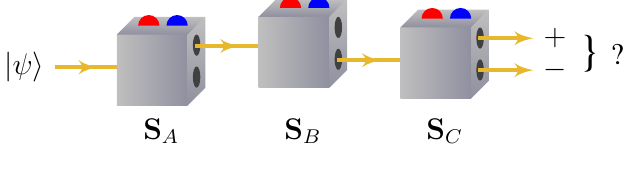
Figure 1. Each box represents a measurement of the spin for a spin- 1 axis with the top output indicating that the state is aligned ( + ) with the measurement axis and the bottom output indicating that the state is anti-aligned ( − ) with the measurement axis. Red and blue lights on the top simply indicate to the experimenter which of the two results is obtained (e.g., red might indicate aligned and blue might indicate